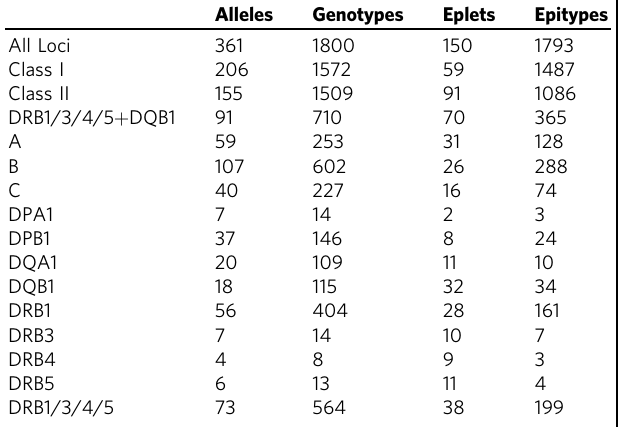
Table 1 Summary of HLA alleles, genotypes, eplets, and epitypes in the total study population of 1846 subjects at various loci combinations and individual loci.